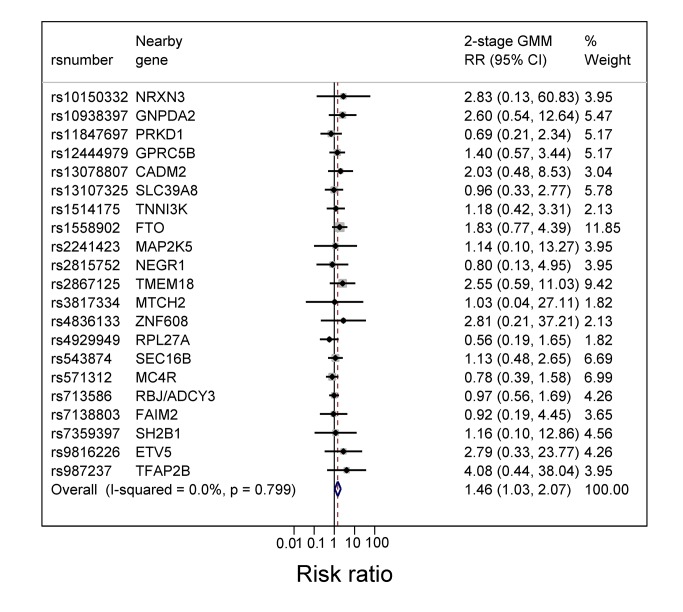
Forest plot of the individual causal effects on current asthma at 7½ y of 32 BMI-related SNPs.The SNPs are those previously reported in a meta-analysis [9] that excluded ALSPAC data. rs2287019 and rs4771122 were omitted from the forest plot because IV RRs were not estimable. Also rs10150332, rs10767664, rs10938397, rs1555543, rs206936, rs2112347, rs2287019, rs2890652, rs381029, rs4771122, rs4836133, rs9816226, and rs987237 were excluded because the corresponding SE (of the log RR) was >2.